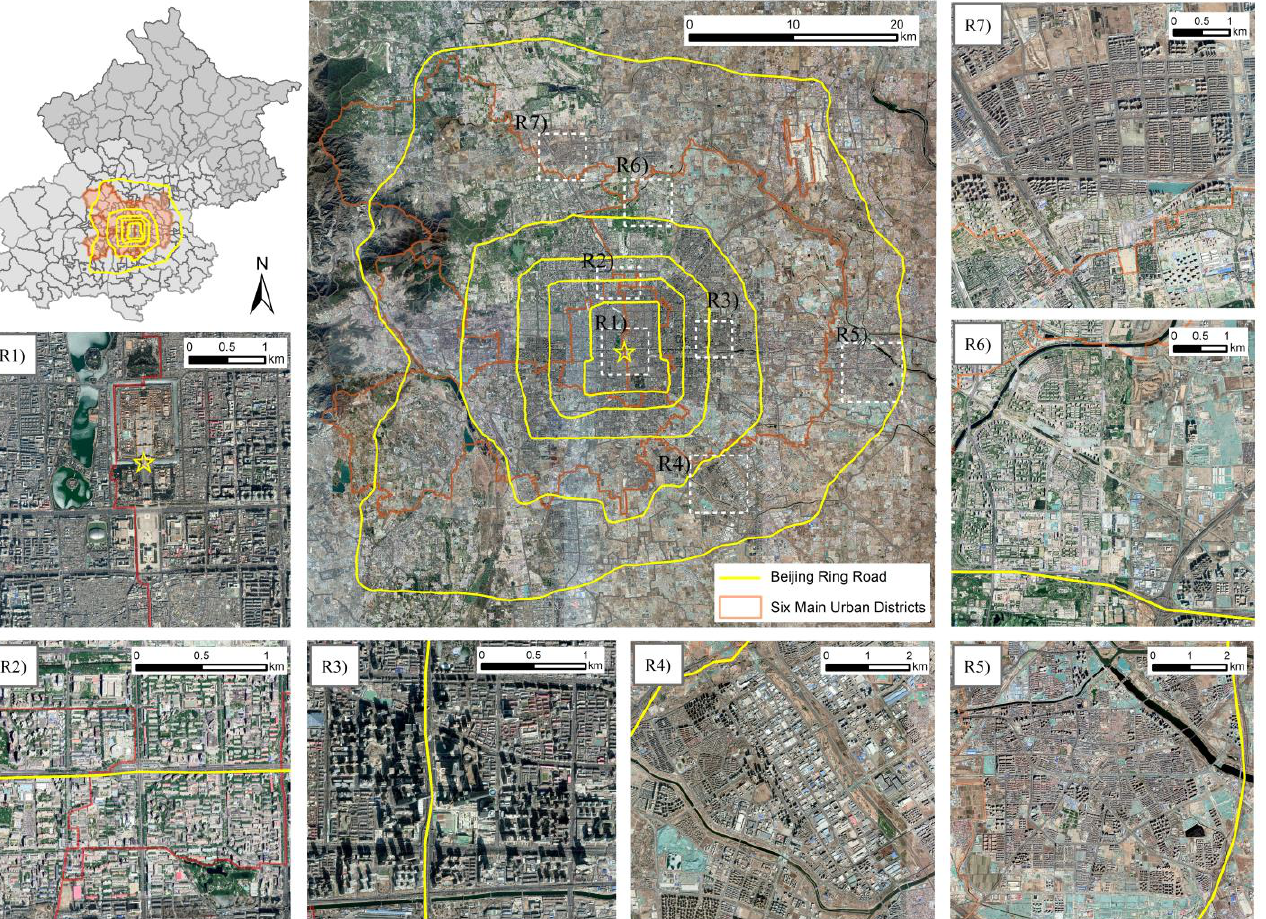
Figure 1. Research areas overlaid on satellite images from Google Earth. The urban core center named Tian’anmen Square is marked by the yellow star. The regions R1 – R3 regions are located within the Fifth Ring Road, representing the high-density built-up areas with high density population and employment centers ( R1 – R3 ). R4 – R7 are located between the fifth and sixth ring roads, as suburban areas ( R4 – R7 ). R5 is the sub-center of the city supported by the local policy, namely Tongzhou New Town. R4 is a high-tech industrial park with a large number of employment facilities ( R5 ). R6 and R7 are large residential areas with a single type of land use ( R6,R7 ).